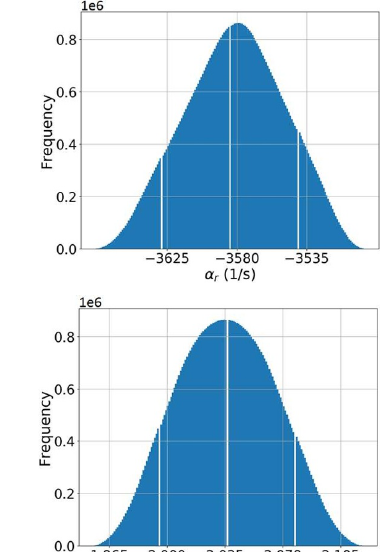
, 𝜶 , 𝜷 , and 𝚲 𝒄𝑻 Against their 𝒄 𝒓 𝒓